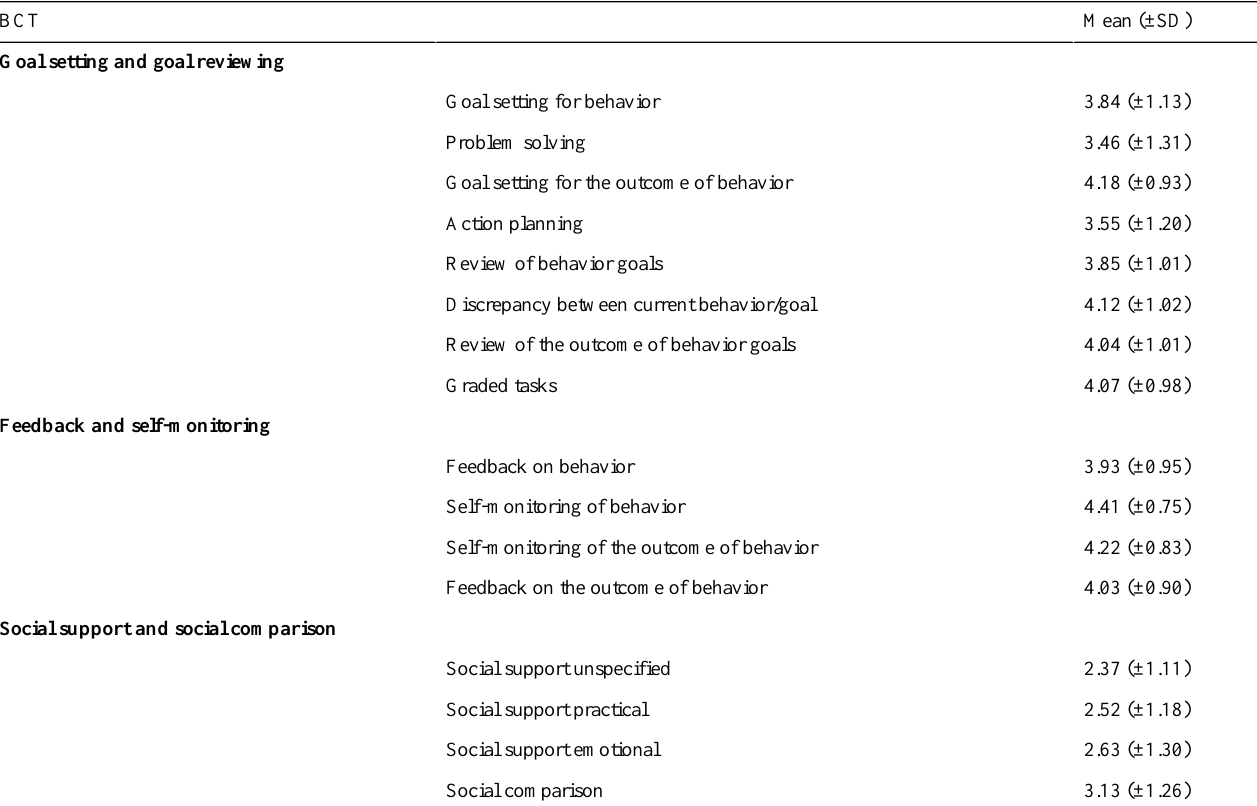
Table 3. Mean preferences for behavior change techniques (BCTs) in a physical activity app a